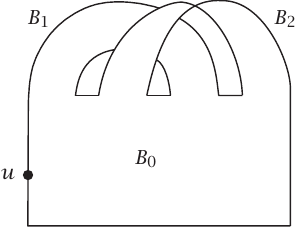
Figure 3.1 . A picture of a decomposed